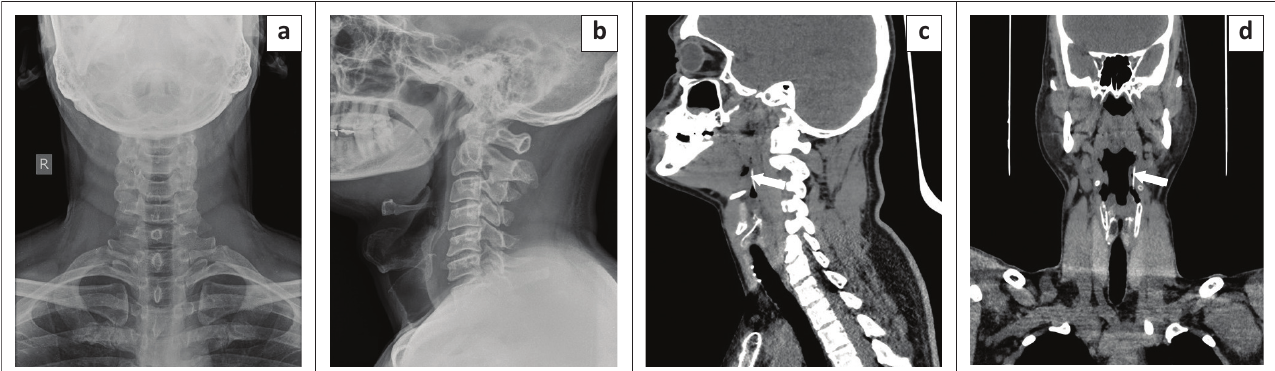
FIGURE 1: Impacted fish bone in a 45-year-old male. Frontal and lateral radiographs of the neck (a and b) show no radio-opaque foreign body. Sagittal (c) and coronal (d) reformatted computed tomography images demonstrate the fish bone (arrows) impacted in the left lateral pharyngeal wall.